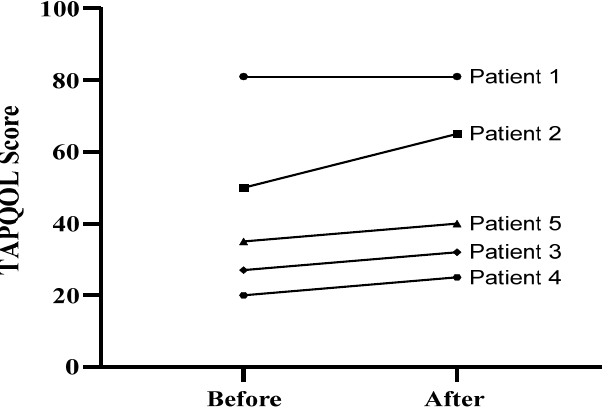
Figure 1. TAPQOL score of five patients at baseline (week 0) and at the end of treatment (week 12).